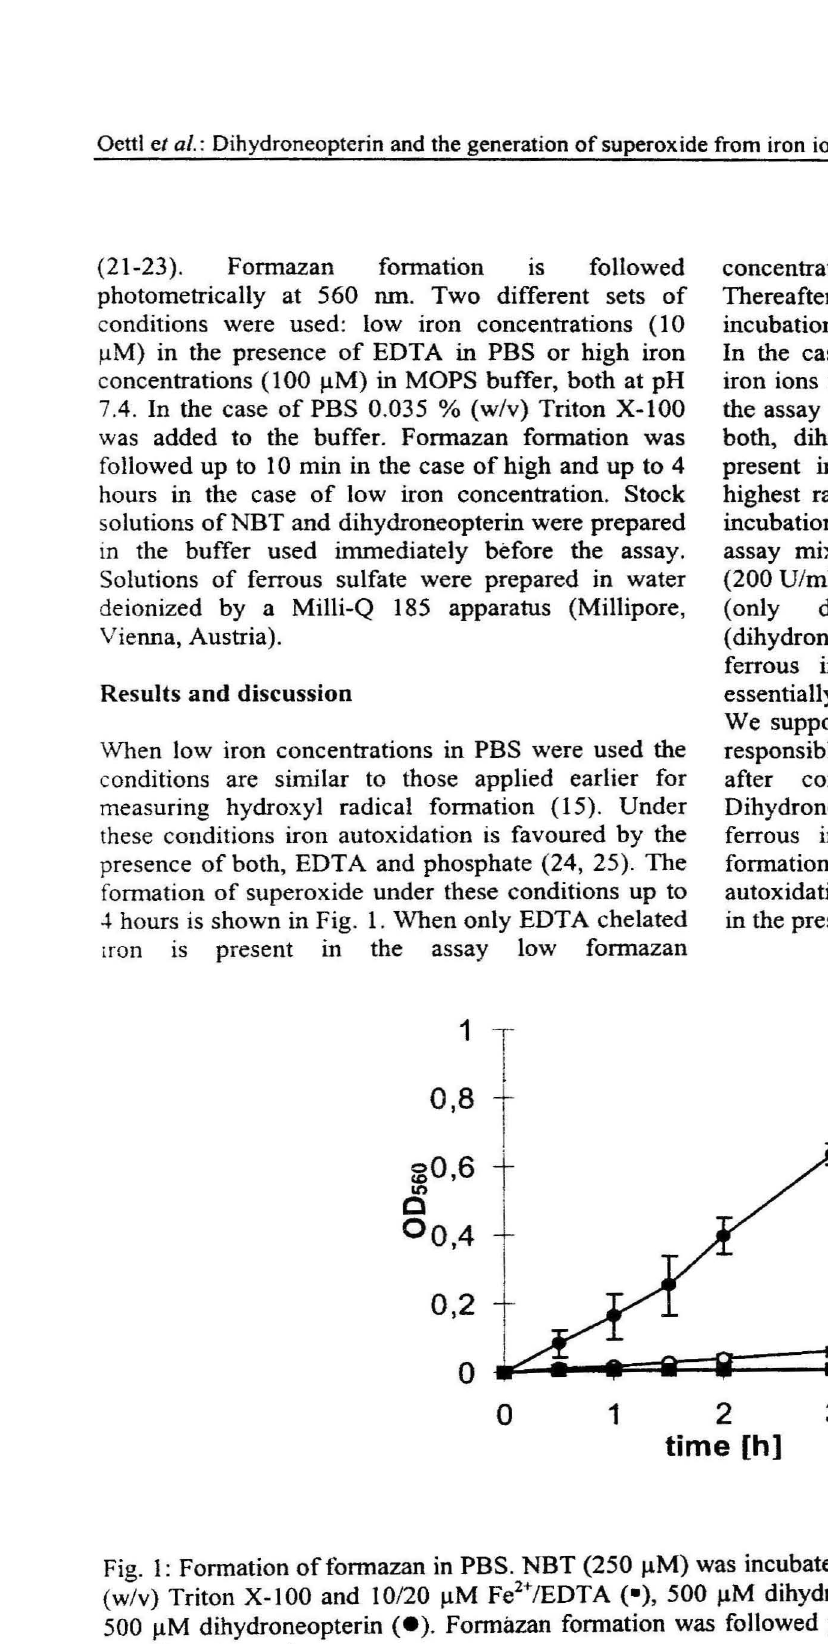
Fig. I: Fonnation offormazan in PBS. NBT (250 J.1M) was incubated in PBS, pH 7.4 in the presence of 0.035 % (w/v) Triton X-IOO and 10120 11M Fe 2 +/EDTA (-), 500 J.1M dihydroneopterin (0), or 10/20 J.1M Fe 2 +/EDTA + 500 11M dihydroneopterin (e). Fonnazan fonnation was followed photometrically. Mean values ± S.D. of two experiments are